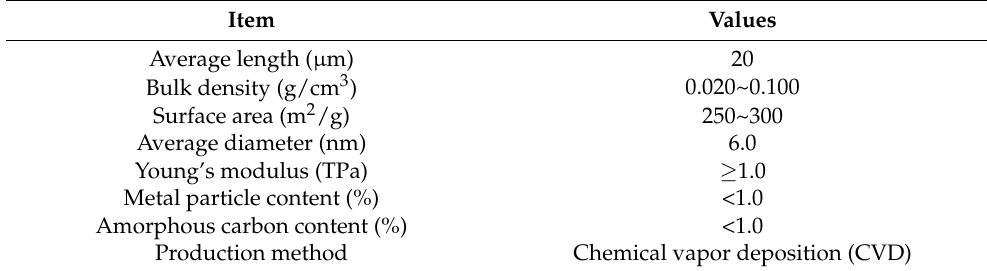
Table 2. Key characteristic properties and technical indices of